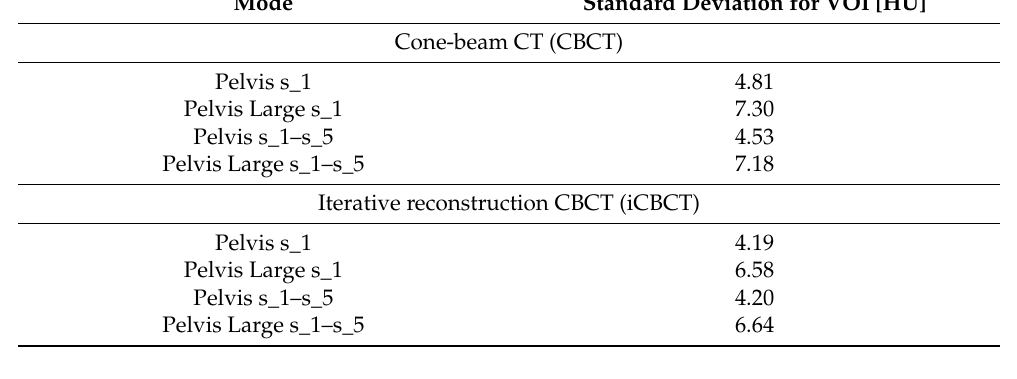
Table 5. Impact of reconstruction algorithms and modes on image uniformity for scanning irradiated PABIG nx in PH-6-DD2 GeVero Co. container with the TrueBeam accelerator equipped with CBCT and iCBCT (1 × 1 cm 2 , 10,000 MU). VOI: 20 mm diameter, 20 mm height. The results are shown for 1 and 1–5 series as a mean (s_1 and s_1–s_5).